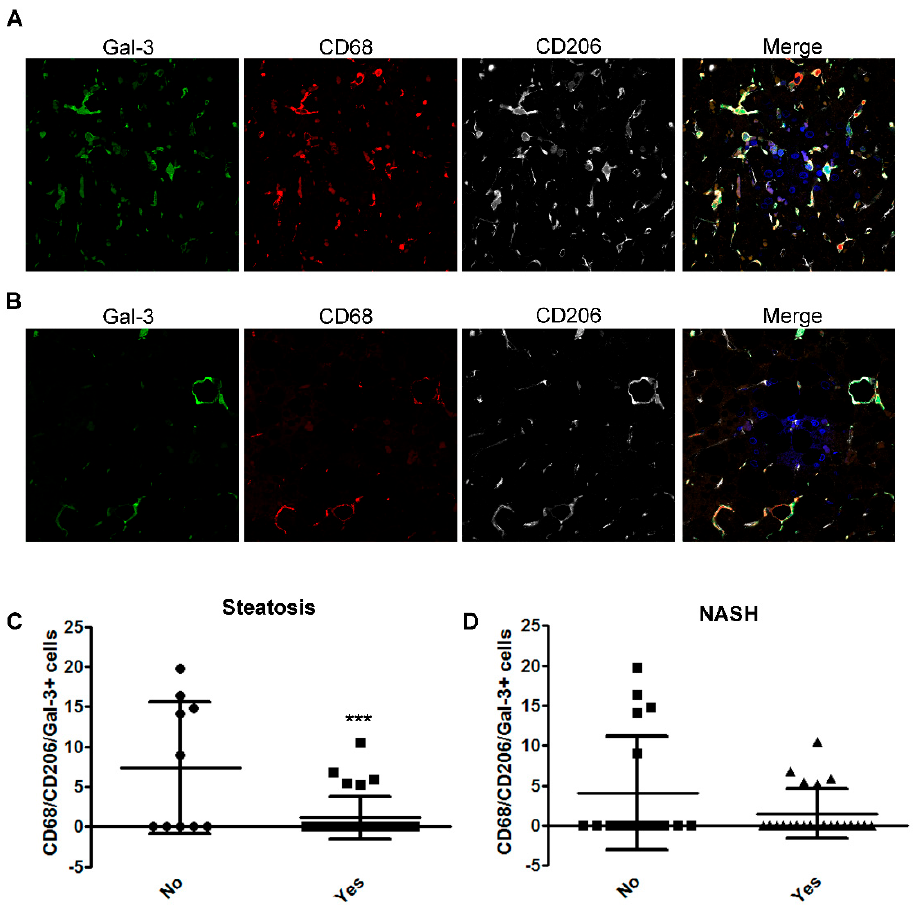
Figure 3. Analysis of the number of hepatic CD68 / CD206 / Gal-3 + cells in children with NAFLD associated with severity of disease. ( A , B ) Representative image of immunofluorescence of Gal-3 (green), CD68 (red) CD206 (grey) in liver tissues from children without NASH ( A ) and with NASH ( B ). Magnification 60 × . Nuclei were counteracted with Hoechst staining (blue). ( C , D ) Mean number of CD68 / CD206 / Gal-3 + cells in the liver tissue from children with NAFLD correlated with the presence (Yes), or not (No) of steatosis and ( C ) NASH ( D ). *** p < 0.001.